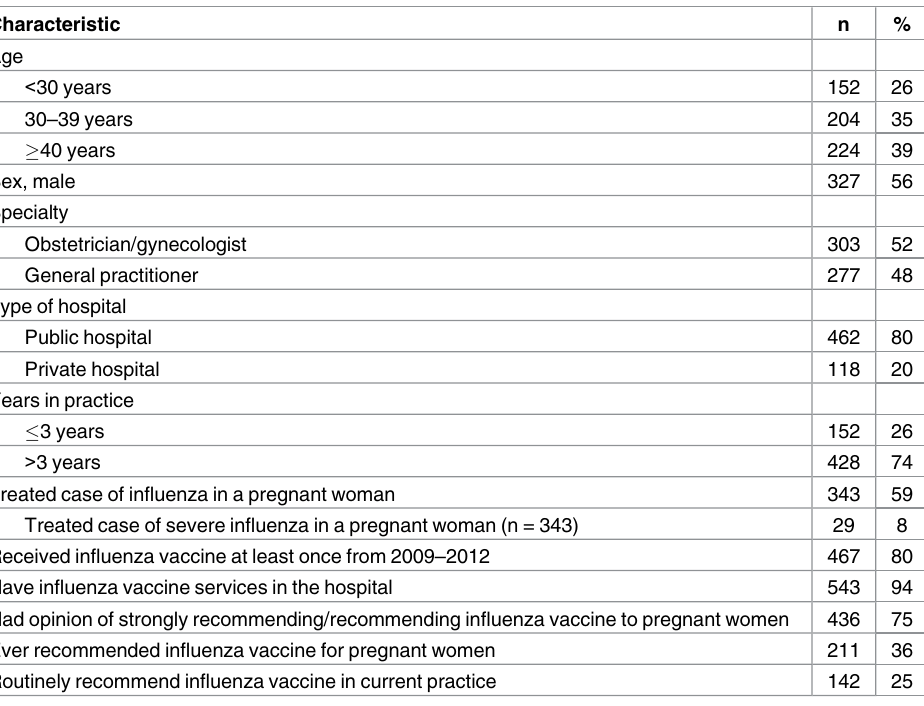
Table 1. Characteristics of Thai physician respondents and their perspectives on influenza vaccine (N =